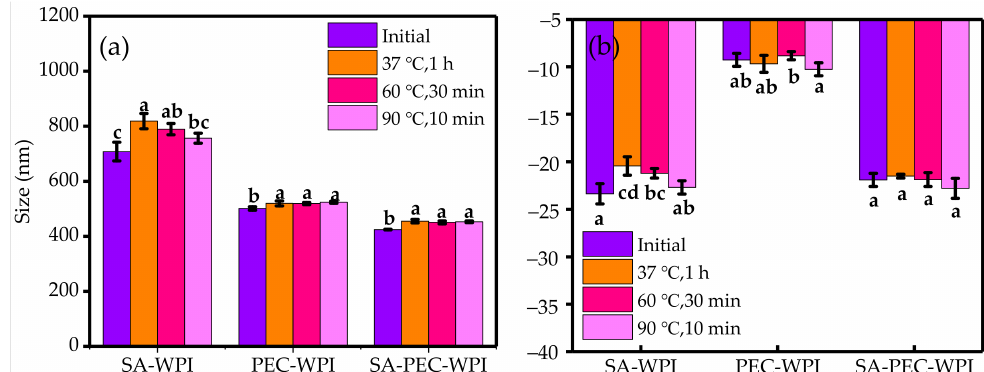
Figure 7. The effect of different thermal treatments on the particle size ( a ) and zeta potential ( b ) of the emulsions. The different letters (a–d) within the figure indicate significant differences ( p ≤ 0.05).